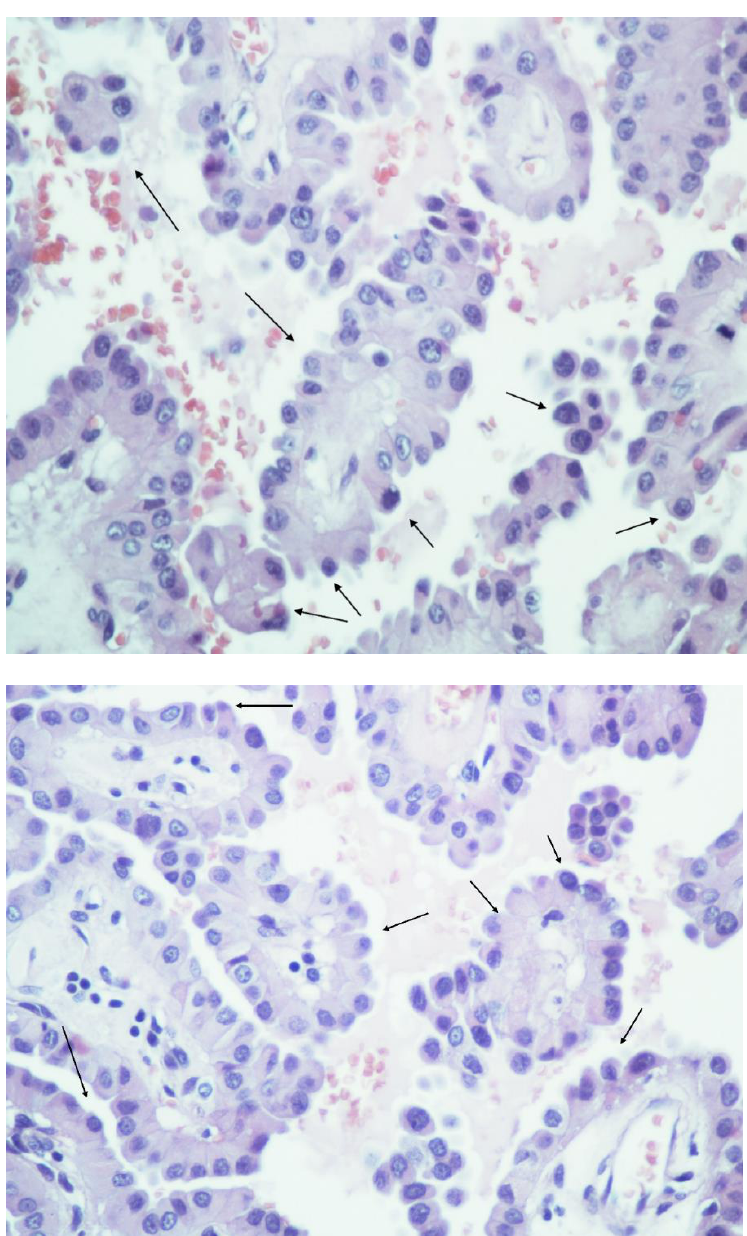
Figure 2. Examples of hobnail papillary thyroid carcinoma (HPTC) with presence of micropapillary structures, hobnail features in the cells with apically placed nuclei, loss of cellular cohesion (HE × 400). Arrows indicate hobnail cells.